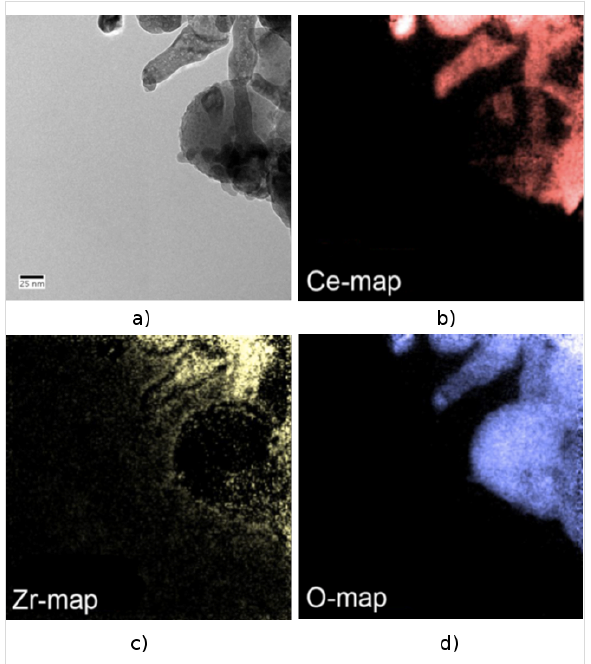
Figure 6: EFTEM, element mapping of calcined ternary oxide CeO 2 / ZrO 2 @SiO 2 microtubes. a) TEM overview of the sample area scanned in the EFTEM experiment. b) Element mapping of cerium (red, Ce). c) Element mapping for zirconia (yellow, Zr). d) Oxygen map which is evenly distributed throughout the scanned sample area (blue, O).